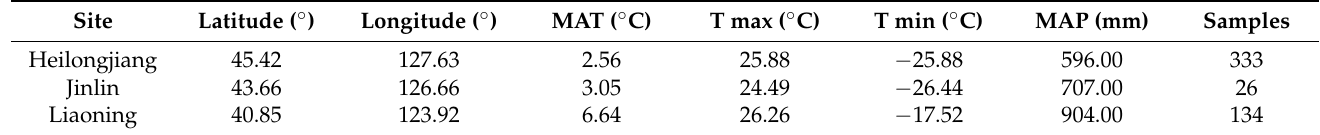
Table 1. Geographic coordinates, temperature, and precipitation at the sites.